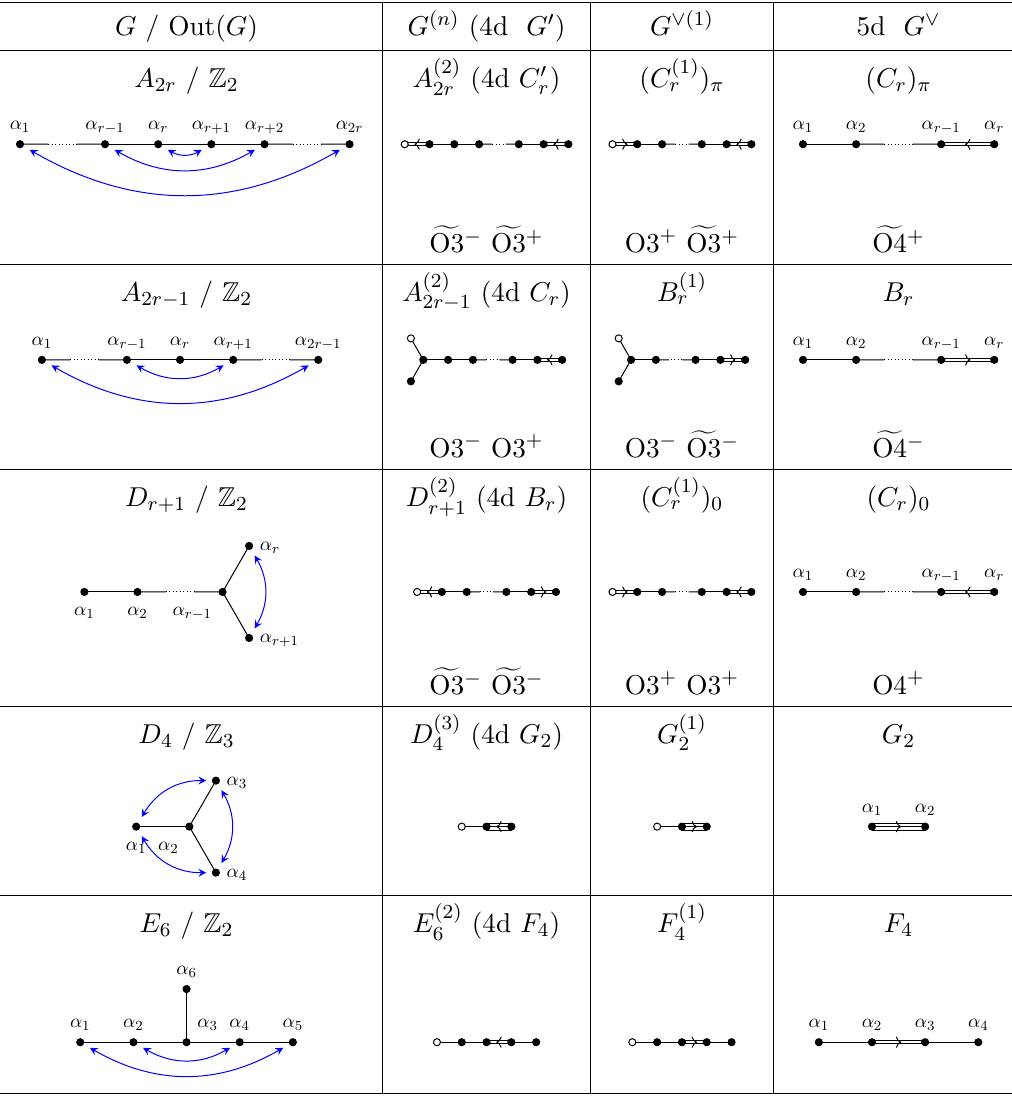
Table 2 . Dynkin diagrams for (affine) Lie algebras along the compactification chain (2.1). Brane interpretation is given when possible. Note that G ( n ) and G ∨ (1) are related by the S-duality